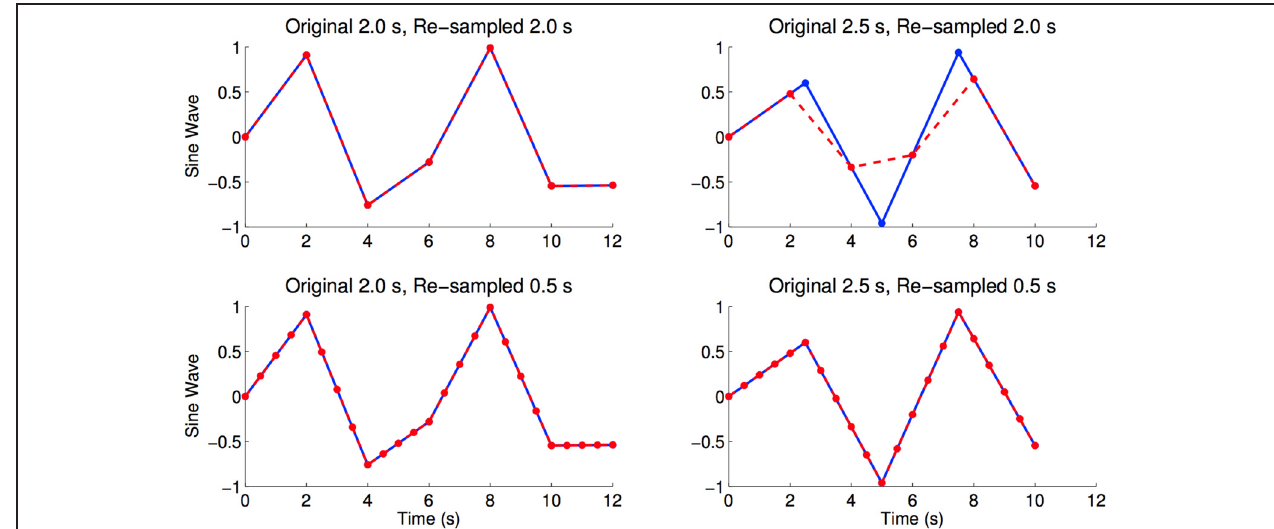
minimum values of the red curve are very different from the blue curve. In the bottom right and bottom left panels we see that linear re-sampling does not have these errors, but acknowledge that the time points in-between originally sampled time points are extrapolated using linear interpolation (Brown et al.,